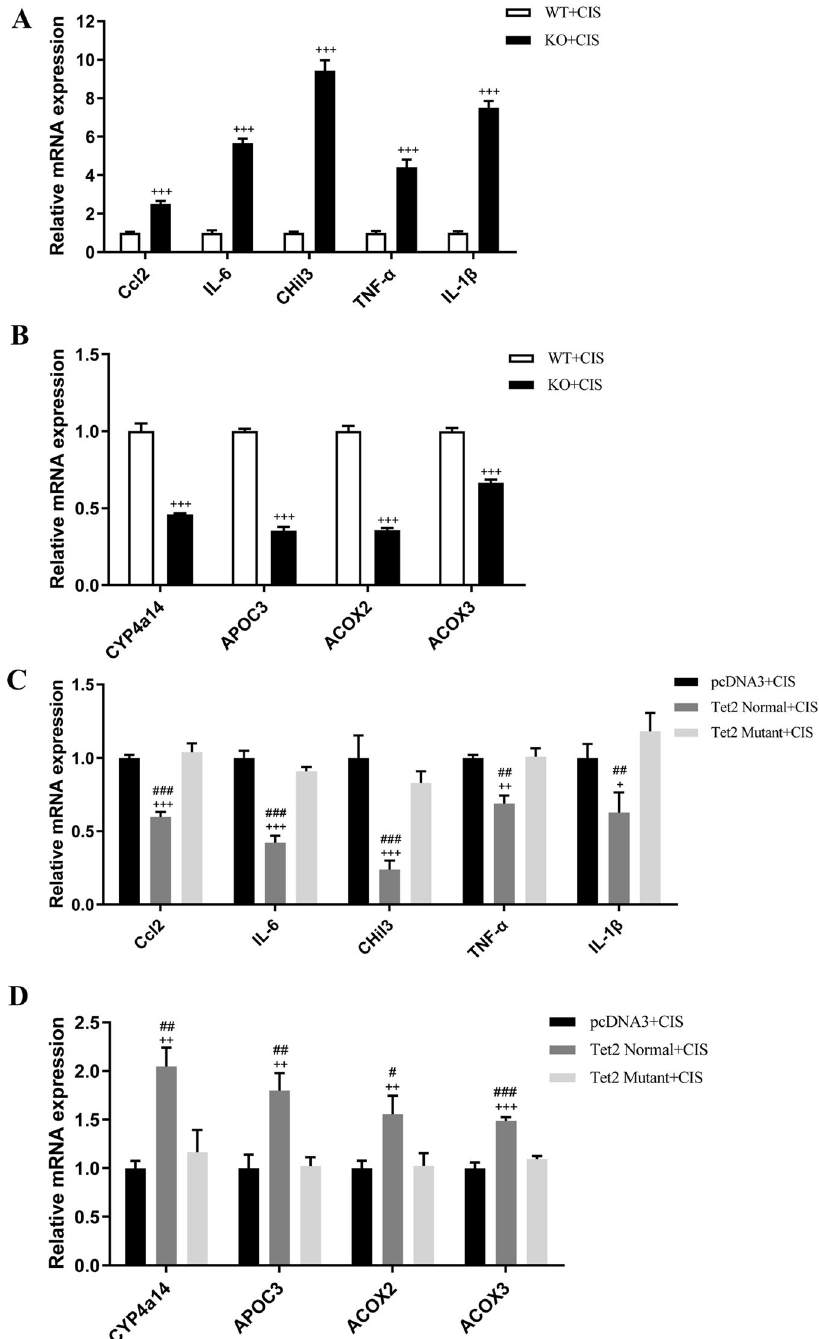
Fig. 6 Quantitative analyses of the metabolic pathways and in fl ammatory genes in mice kidney ( n = 3). A , B qPCR analysis of the indicated genes mRNA levels in WT and Tet2 -KO mice kidney after cisplatin treatment. C , D qPCR analysis of the indicated genes mRNA levels in Tet2 overexpression and control mice kidney after cisplatin